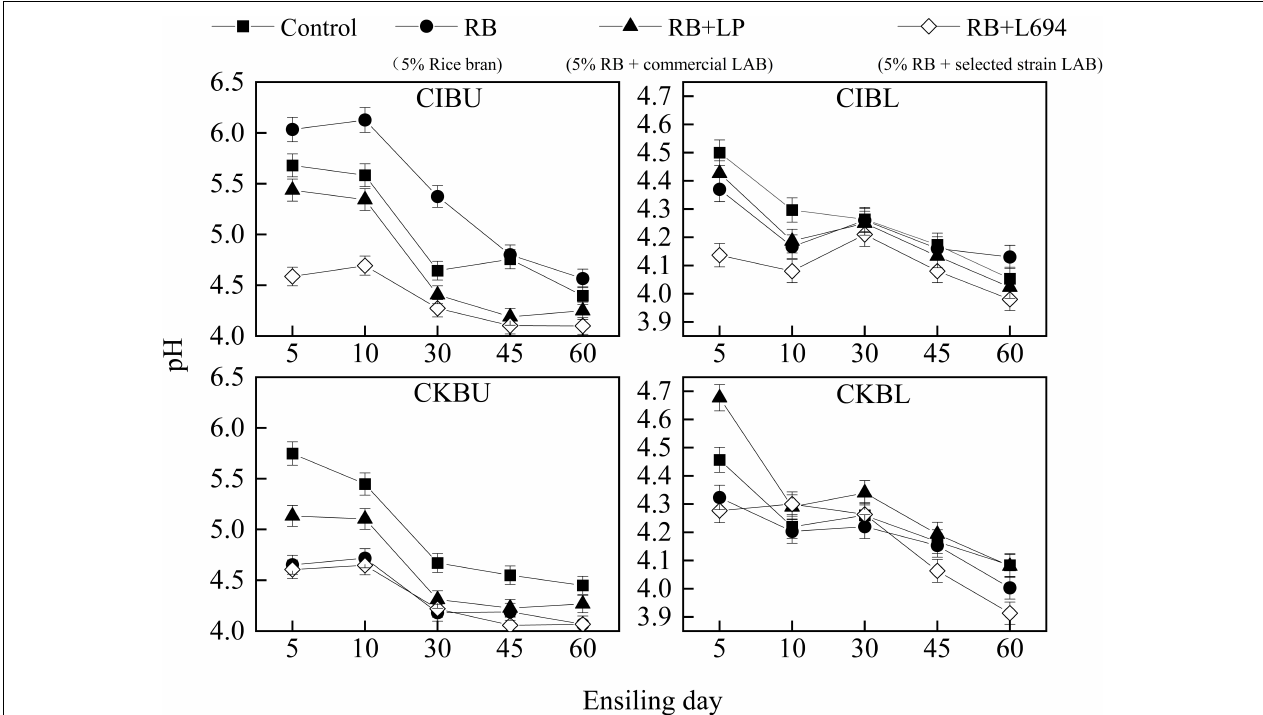
FIGURE 1 | pH dynamics of Caragana intermedia (CI) and Caragana korshinskii (CK) silages at the budding (BU) and blooming stages (BL) during ensiling. RB, 5% rice bran; LP, commercial inoculant strain Lactobacillus plantarum ; L694, a selected strain Lactobacillus ( n = 3).